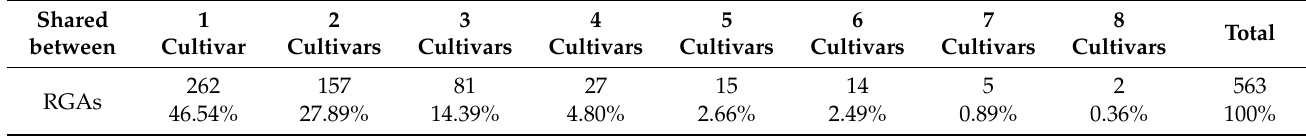
Figure 6. Circos plots showing the number of RGAs with the same CNV events among eight winter type and blackleg resistant B. napus cultivars. Each ribbon shows number of RGAs with CNV in common, the wider ribbon, the highest number of RGAs with the same CNV. Table 3. The number and percentage of RGAs with CNV shared among the